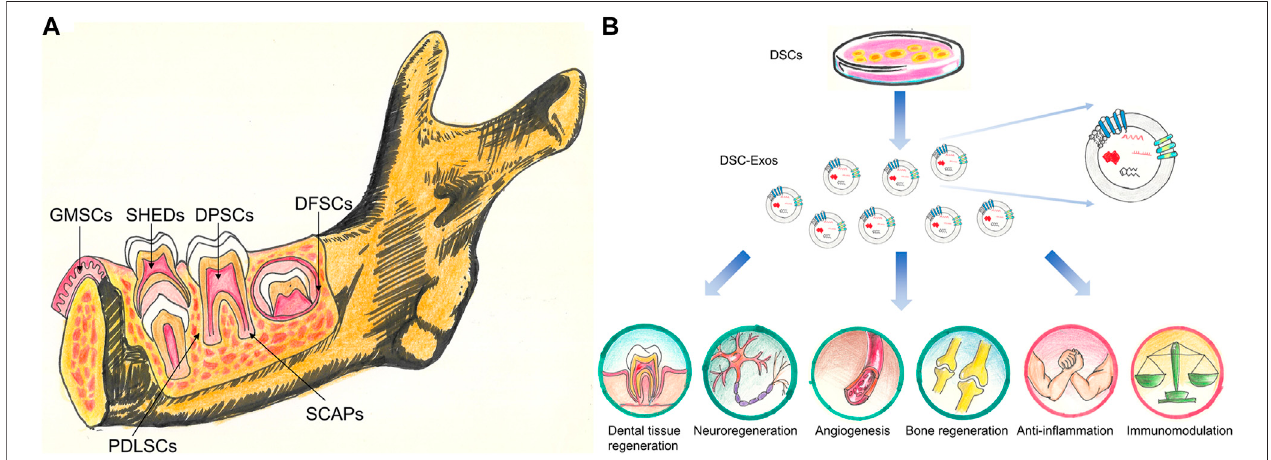
FIGURE 1 | (A) Stem cell populations derived from different dental tissues. DPSCs, stem cells from dental pulp; SHEDs, stem cells from human exfoliated deciduous teeth; PDLSCs, stem cells from PDL; DFSCs, stem cells from dental follicle; SCAPs, stem cells from the apical papilla; GMSCs, stem cells from gingival tissues. (B) The potential clinical application of DSC-Exos. DSC-Exos hold great promise for dental tissue regeneration, neuroregeneration, angiogenesis, bone regeneration, anti-in fl ammation and